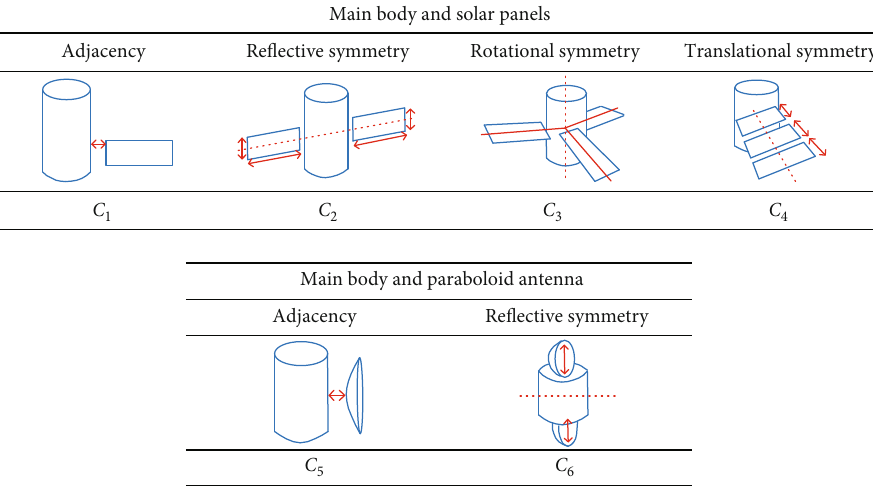
Figure 3: The constraints among the components of typical space objects considered in this paper. Table 1: Detailed constraints of re fl ective